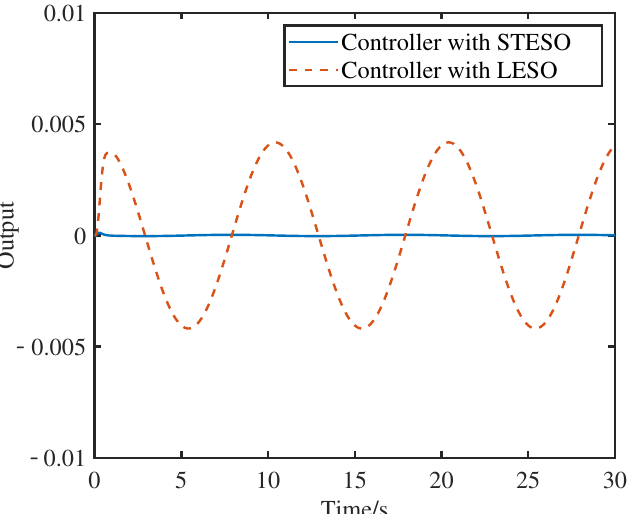
Figure 3. Simulation results of sinusoidal disturbance—system out: controller with STESO (solid line); controller with LESO (dashed